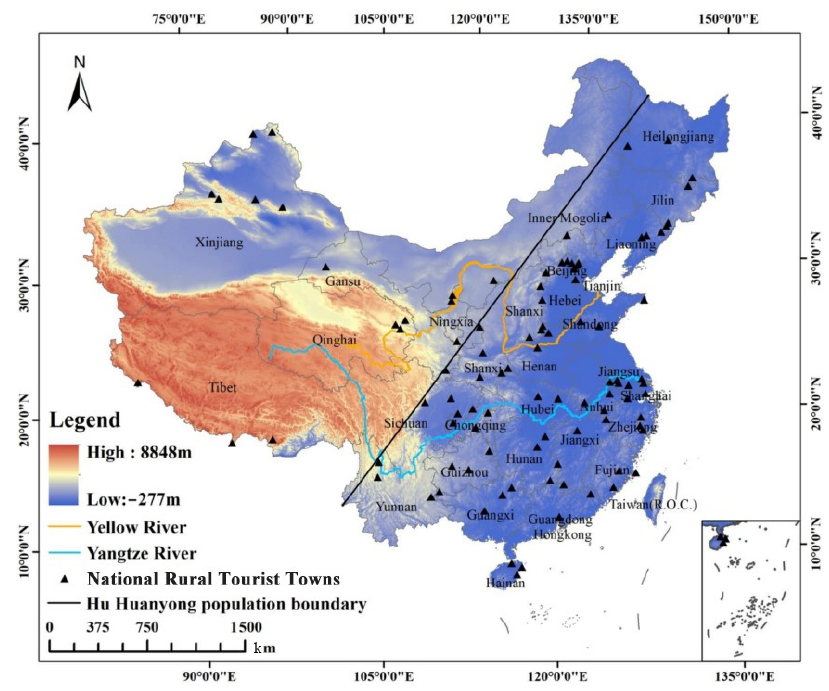
Figure 7. The spatial distribution of NRTTC as divided by Hu Huanyong’s population